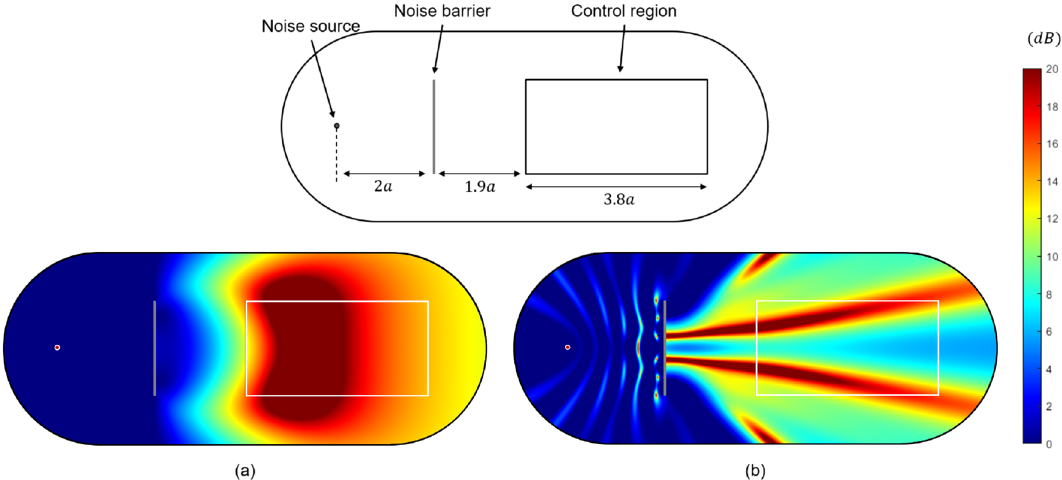
Figure 6. The cross-section of the simulation model on the r − z plane (top). Insertion loss on the r − z plane: ( a ) ka = 0.95 and ( b ) ka = 9.5 .